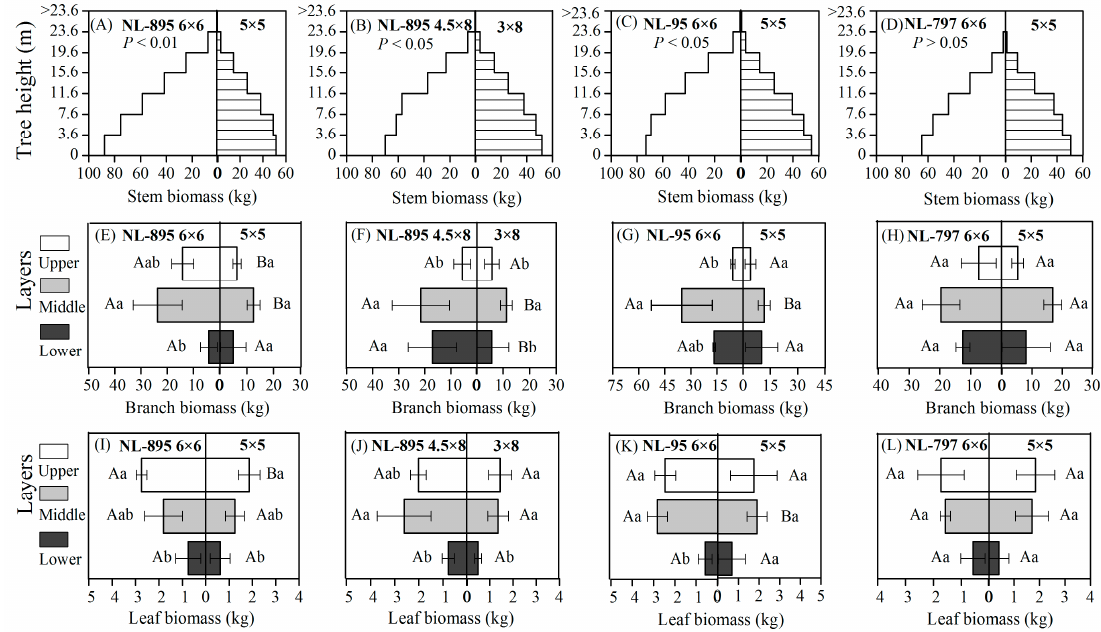
Figure 3. Effects of poplar clones and planting spacings on the vertical biomass distribution in stem ( A – D ), branches ( E – H ), and leaves ( I – L ) for the 13-year-old trees. Different capital letters indicate significant differences ( p < 0.05) by Tukey test between the two spacing treatments at the same layer. Different small letters indicate significant differences ( p < 0.05) by Tukey test between the lower, middle, and upper layers of crown.